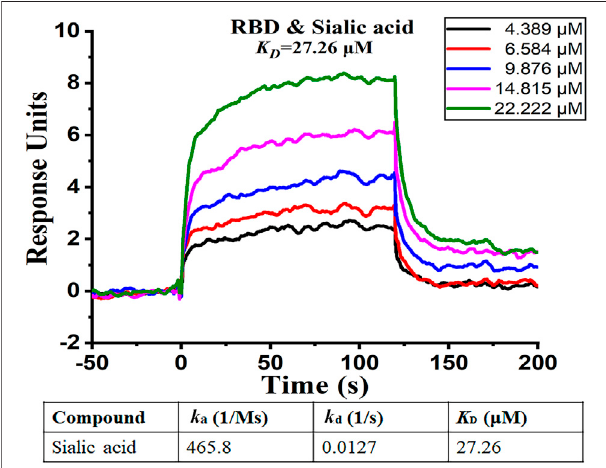
FIGURE 6 | SPR analysis of binding af fi nity between sialic acid and RBD domain. The fi gure shows different levels of response with different sialic acid concentrations. The curve suggests the presence of binding between sialic acid and the RBD domain.